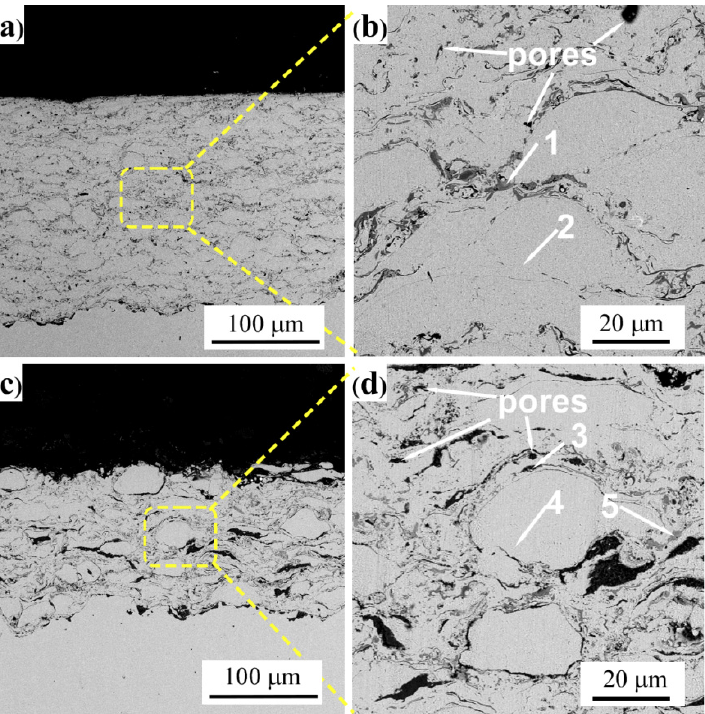
Figure 3. Cross-sectional morphologies of these of the coatings: ( a , b ) CoNiCrAlY coating; ( c , d ) CoNiCrAlY-Al 2 O 3 coating.